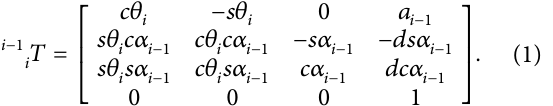
Table 1: The link parameters of the PUMA560.